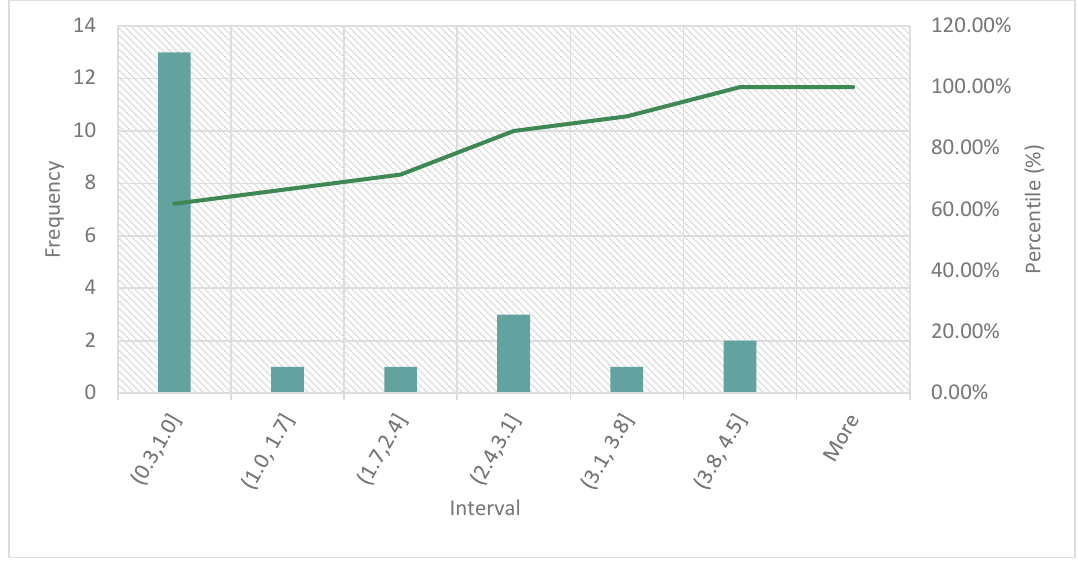
Fig. 4: Histogram and Pareto Graphic for Secchi Disk in Polk County